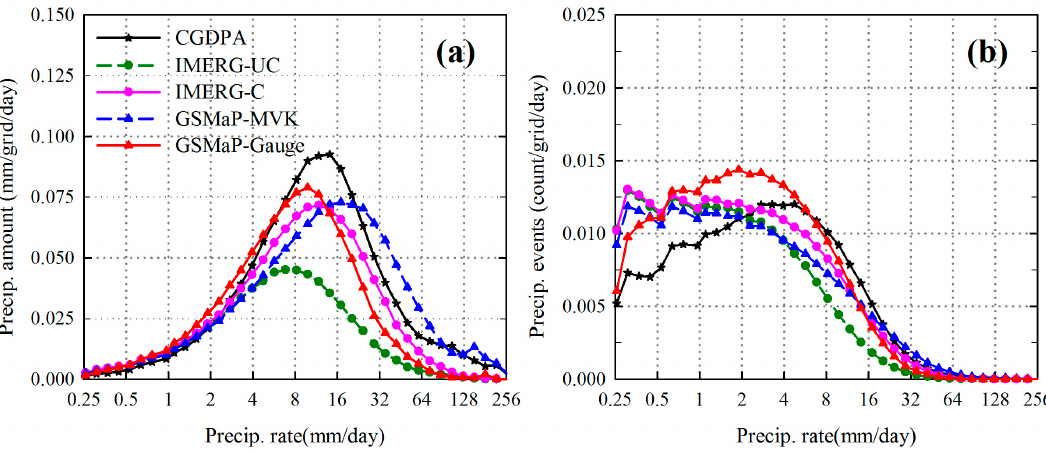
Figure 3. Intensity distribution of ( a ) daily precipitation amount (mm · day − 1 ) and ( b ) precipitation events (count per day) from the four satellite precipitation estimates at the TP. The logarithmic scale was used to bin the precipitation rates.